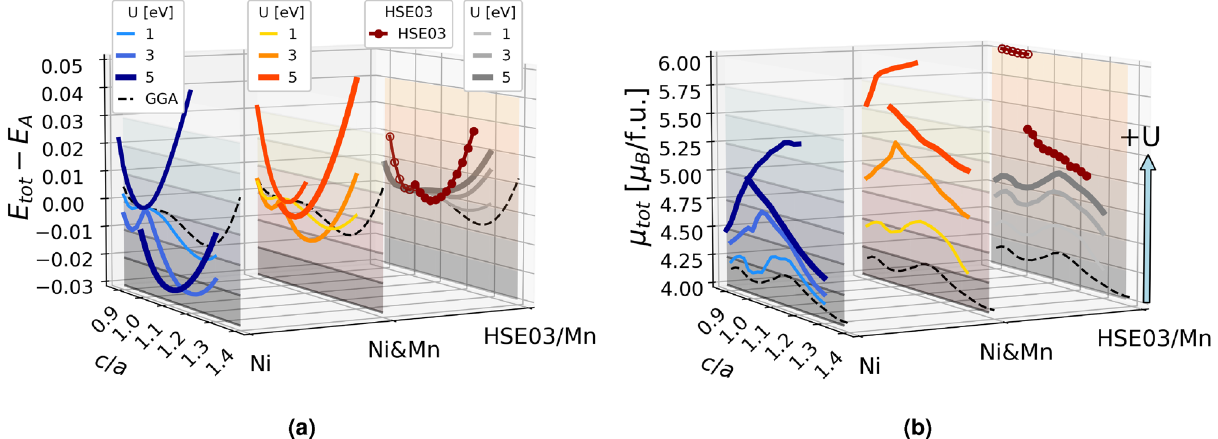
Figure 3. Comparison of ( a ) total energies, and ( b ) corresponding total magnetic moments per formula unit µ tot (plotted on the z axis) along the tetragonal deformation path ( c / a on x axis), calculated using HSE03 and DFT +U (U on Ni in blue, U on Ni and Mn in orange, U on Mn in grey). Standard GGA results are represented by black dashed lines. Energies are plotted relative to the energy of the austenite phase. 2D representation of Fig. 3 can be found in the Supplementary Information SI Fig.